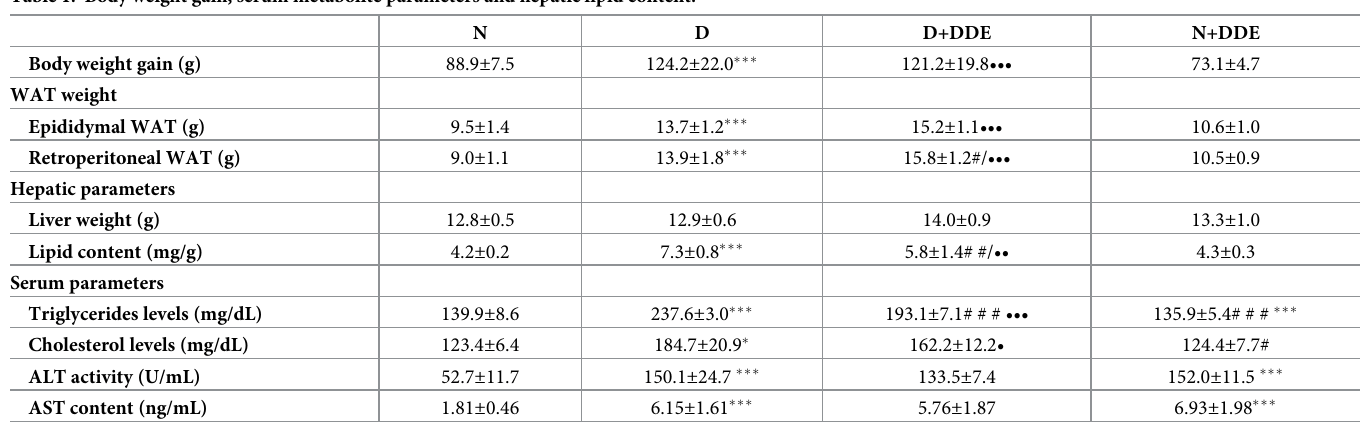
Table 1. Body weight gain, serum metabolite parameters and hepatic lipid content.